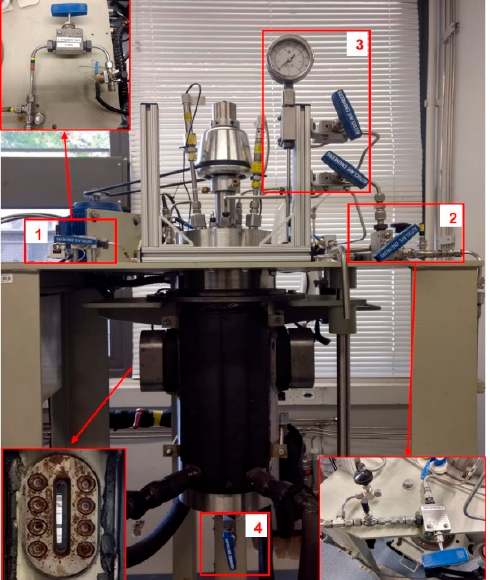
Figure 2. Illustration of the 10 L reactor showing the described features of the system. (1) First sampling point; (2) second sampling point; (3) purge system; and (4) water sampling point.